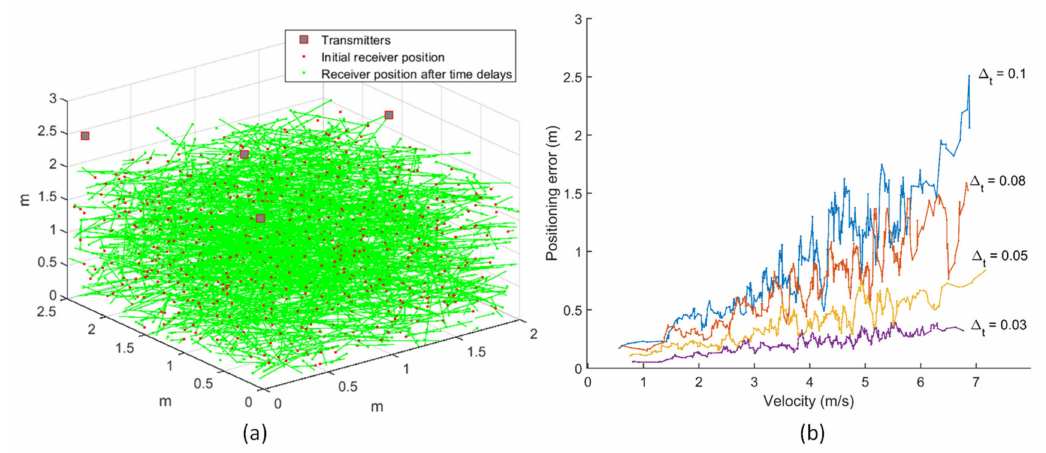
Figure 11. ( a ) Transmitter arrangement and receiver motion. ( b ) Error in positioning due to receiver velocity for various time